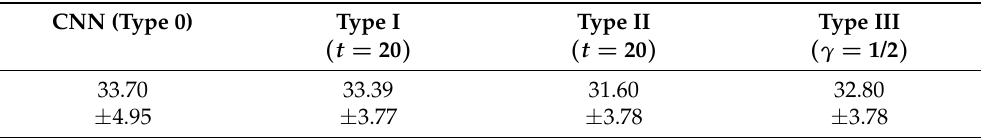
Table 1. Average error rates of the CNN without (type 0) and with image correction methods of type I, II, and